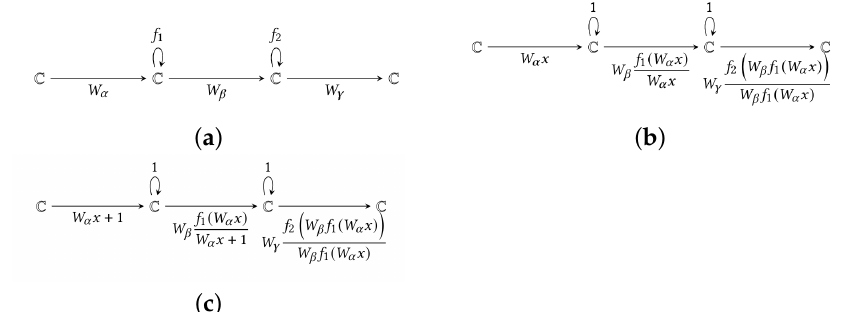
Figure 9. ( a ) A neural network (W,f). ( b ) The induced thin quiver representation W f x considered as a neural network ( W f x ,1 ) and obtained after feed-forwarding x through ( W , f ) . It can be seen that feed- forwarding a unit vector 1 through W f x (i.e., Ψ ( W f x ,1 )( 1 ) ) gives the same output than feed-forwarding x through ( W , f ) : Ψ ( W f x ,1 )( 1 ) = Ψ ( W , f )( x ) . We refer to Theorem 2 for the general case. ( c ) In the case W α x = 0, we can add 1 to the corresponding pre-activation in W f x to prevent from a division by zero, while on the next layer we consider W α x + 1 as the